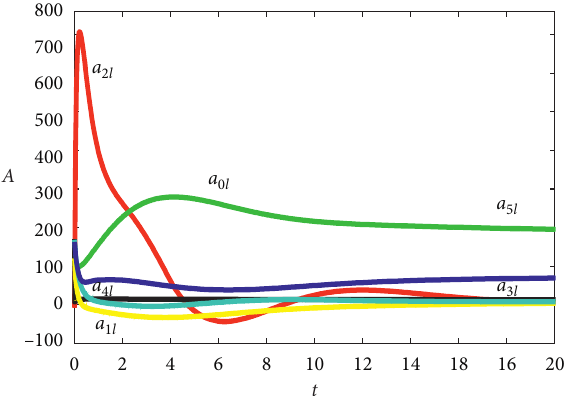
Figure 12: Transient behaviors of a